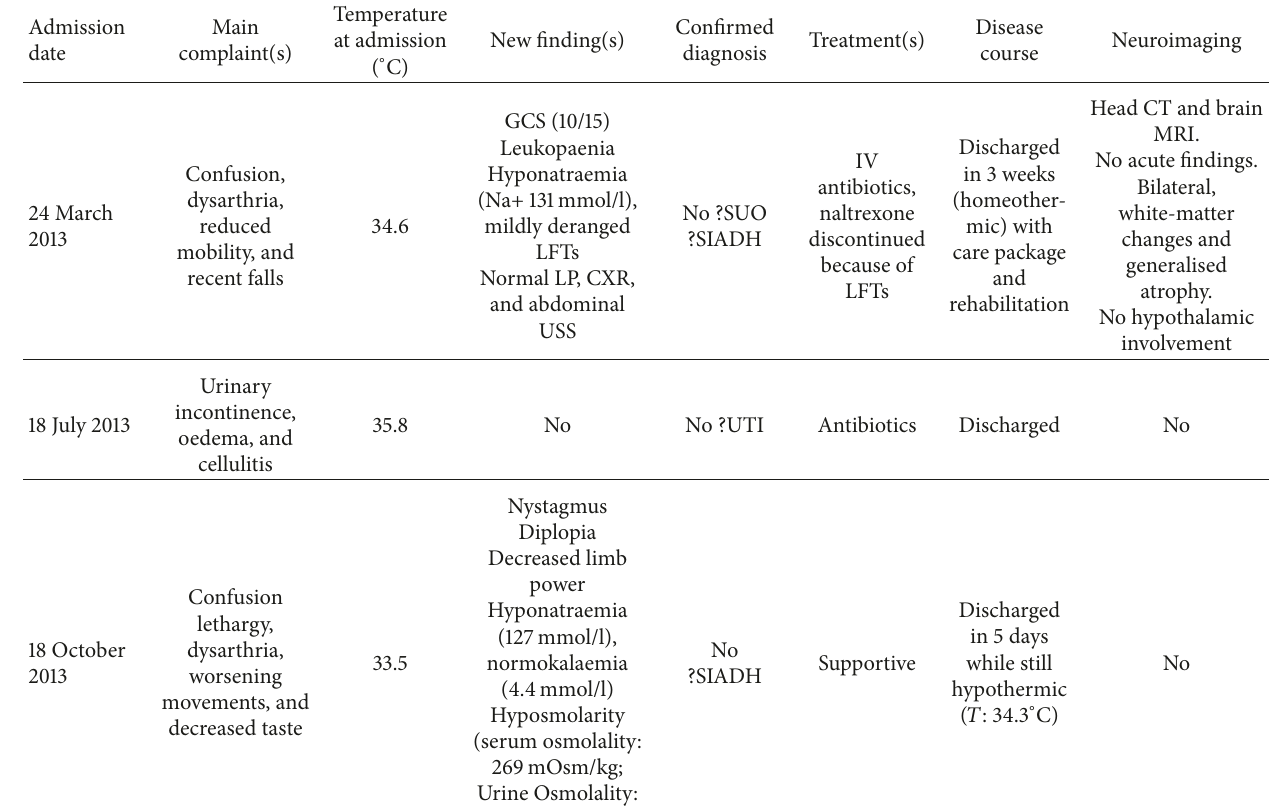
Table 1: Summary of patient admissions to hospital between March 2013 and March